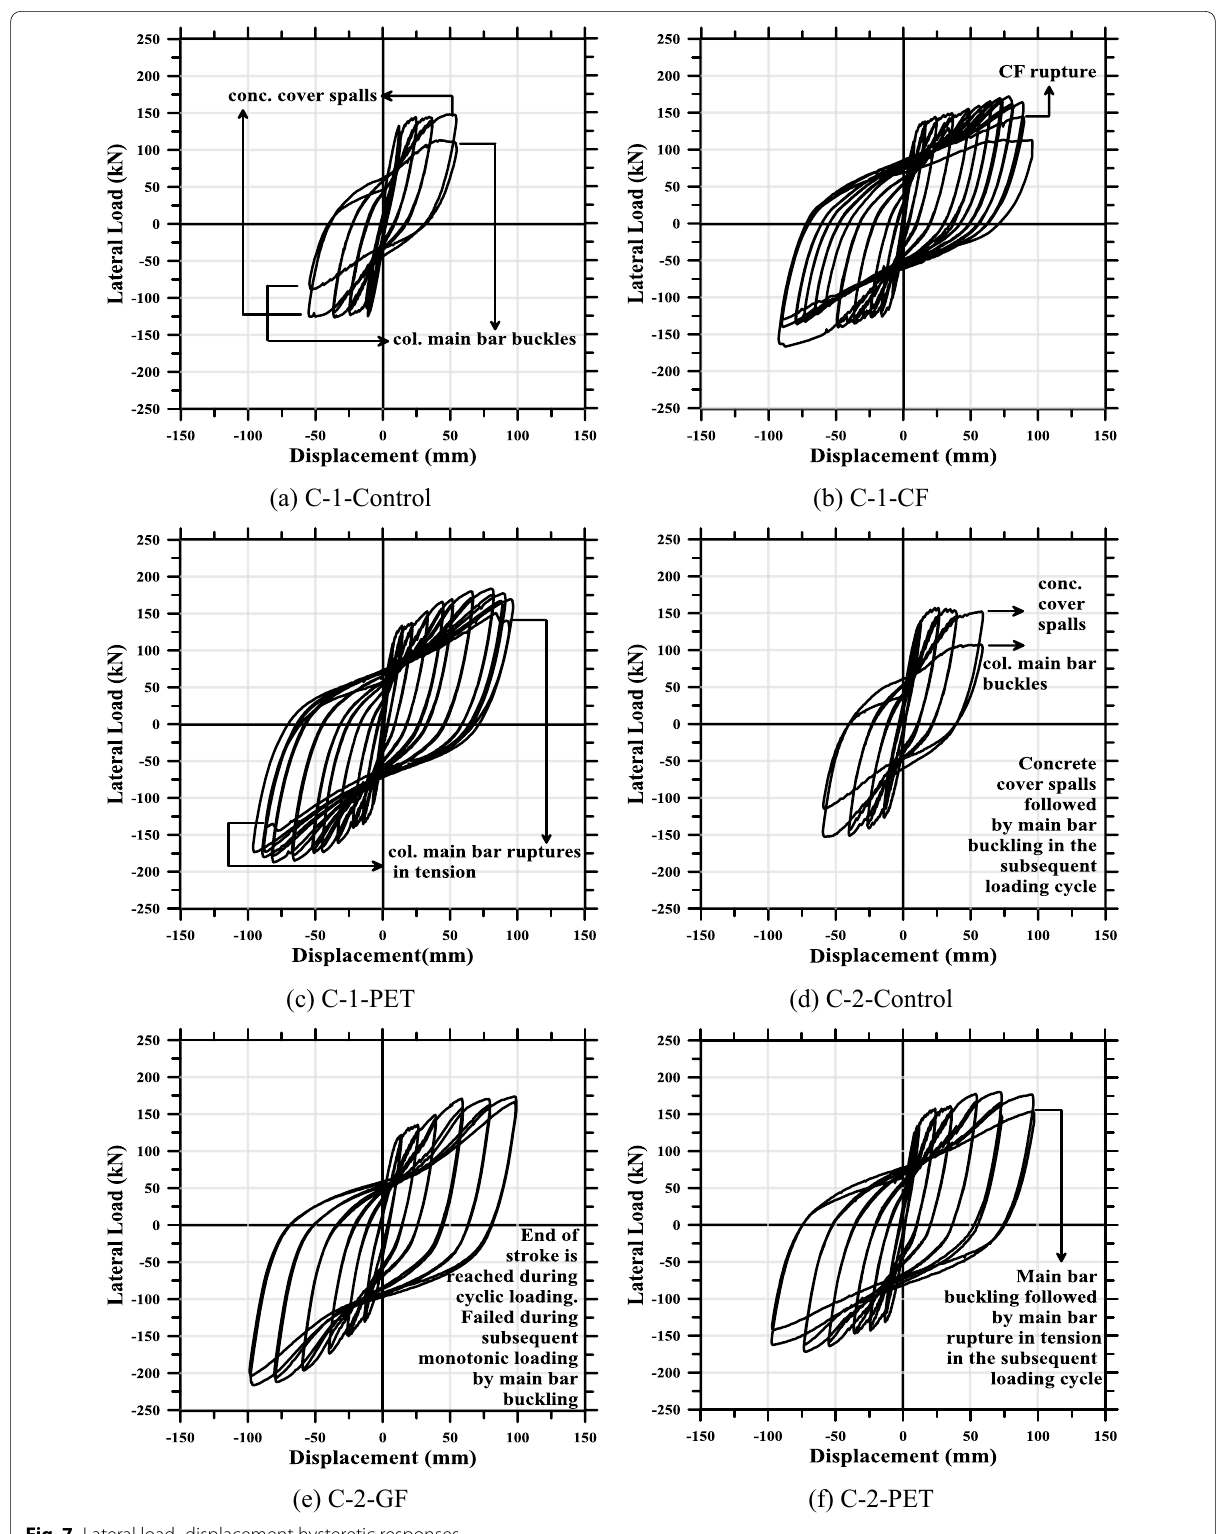
Fig. 7 Lateral load – displacement hysteretic